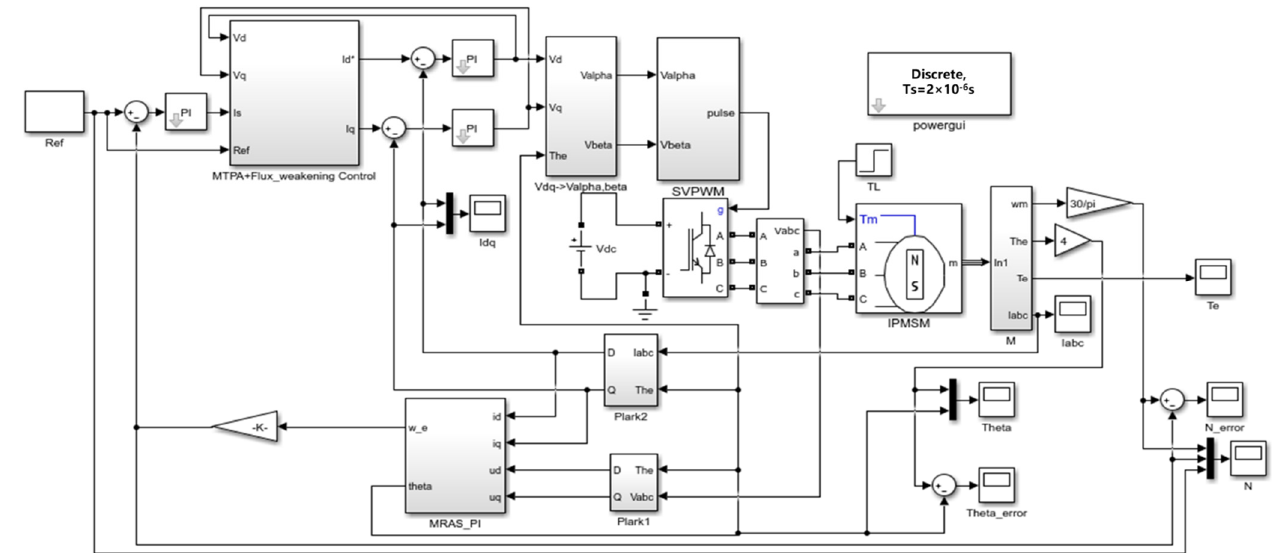
Figure 5. Block diagram of MRAS control system based on stator current. The simulation model of the MRAS control system based on stator current is built in a Matlab/Simulink environment, as shown in Figure 5. The motor parameters used in the simulation are shown in Table 1. Table 1. IPMSM parameters. Parameter (Unit) Value stator resistance R / Ω 0.958 d axis inductance L d /mH 5.25 q axis inductance L q /mH 12 number of pole ‐ pairs P 4 magnet flux linkage 𝜓 (cid:3033) /Wb